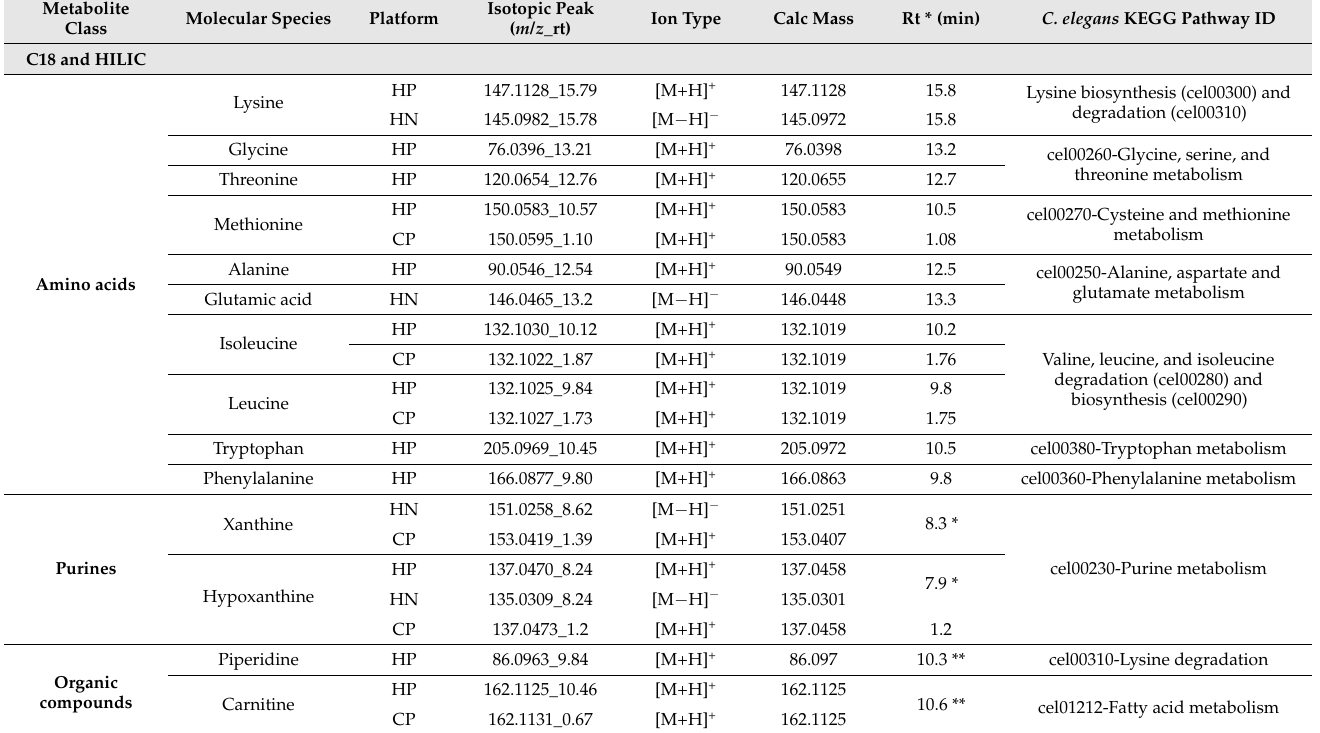
Table 1. Summary of Compounds Identified Across All Metabolomics